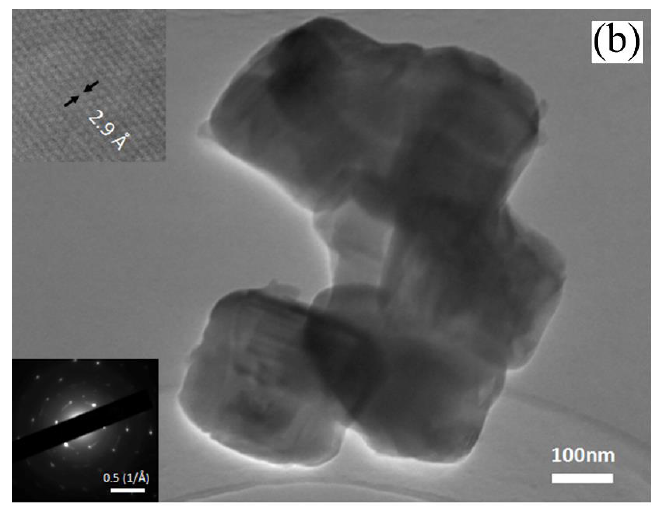
Figure 6. ( a ) SEM and ( b ) TEM images of Al 8 B 4 C 7 product powder prepared in 95%NaCl + 5%NaF at 1250 °C for 6 h.